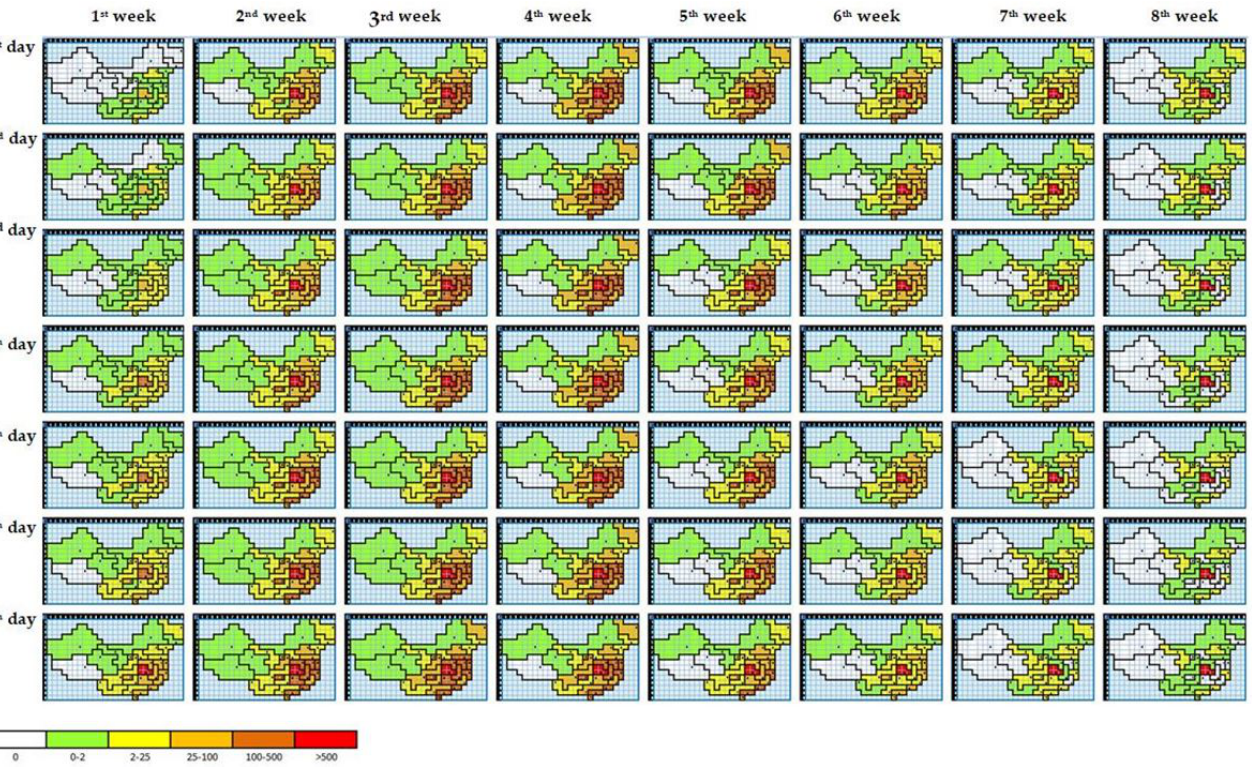
Figure 8. The COVID-19 spreading pattern in China for 8